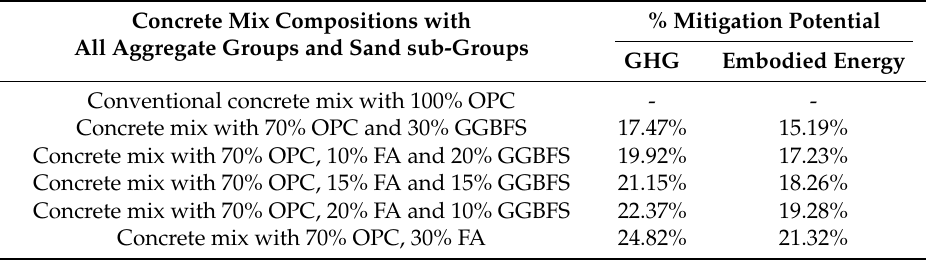
Table 4. Concrete mix wise GHG emissions and embodied energy consumption mitigation potential.